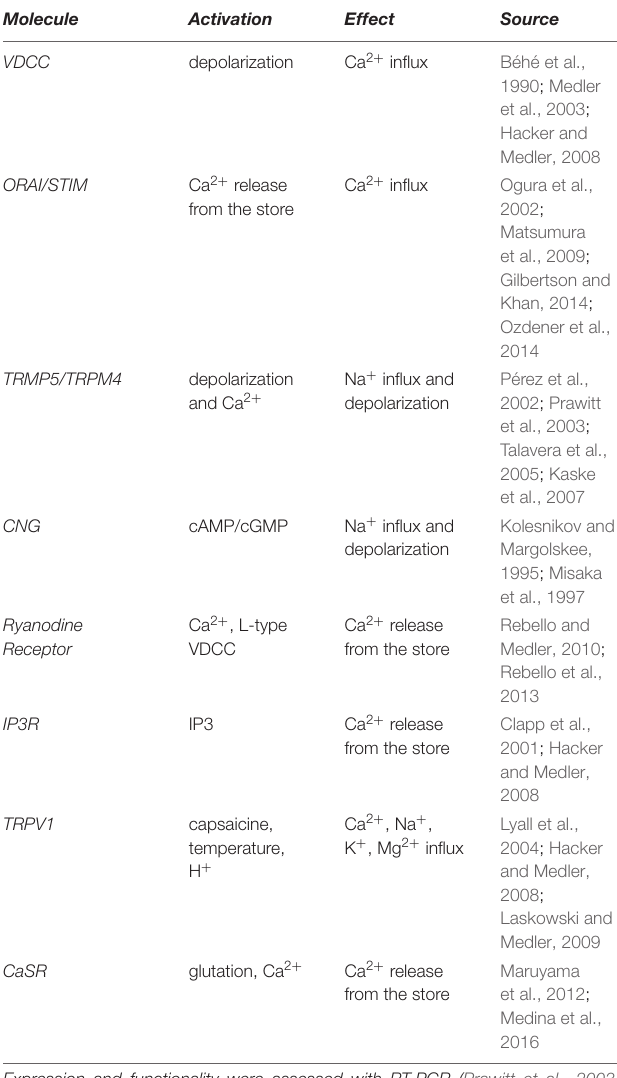
TABLE 5 | Possible Ca 2 + signaling pathways in type II taste bud